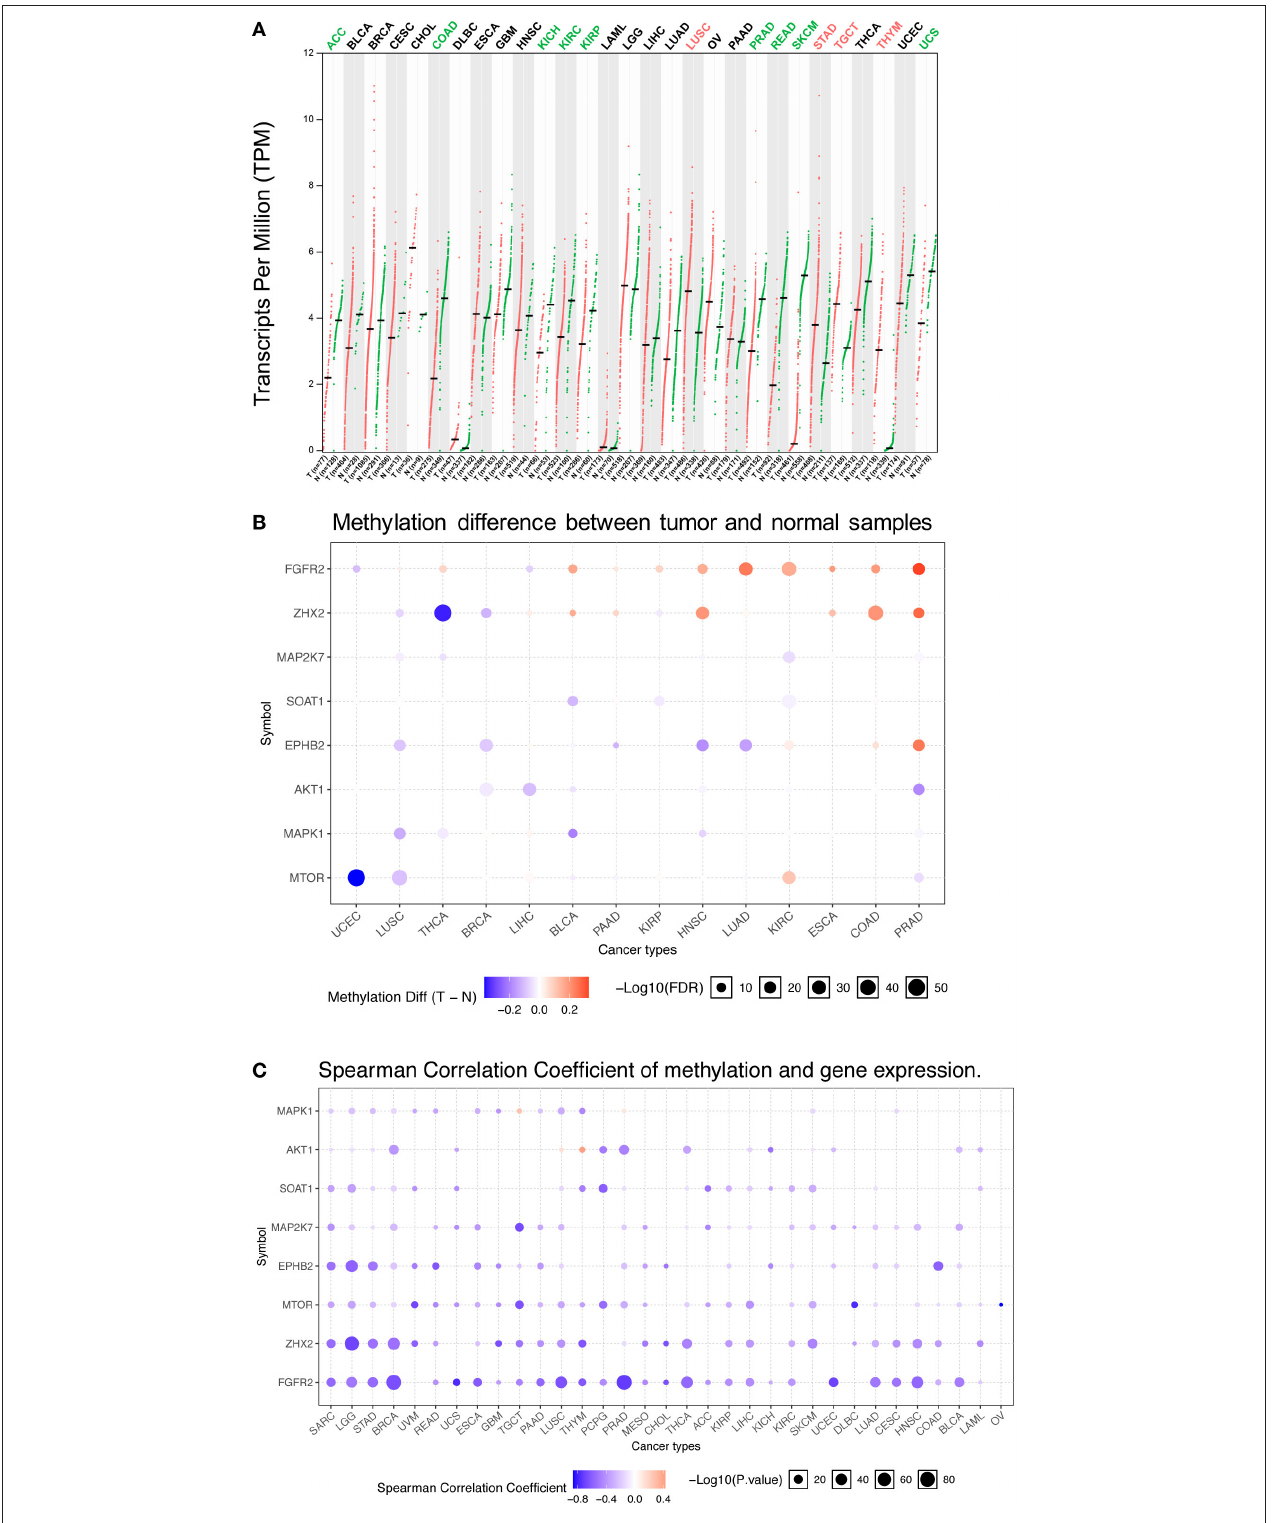
FIGURE 1 | FGFR2 mRNA expression and methylation in TCGA cancer tissues. (A) FGFR2 mRNA expression between tumors and the corresponding normal tissues across TCGA cancer types from GEPIA. (B) Bubble map of the differential methylation of FGFR2 and downstream genes between tumors and the